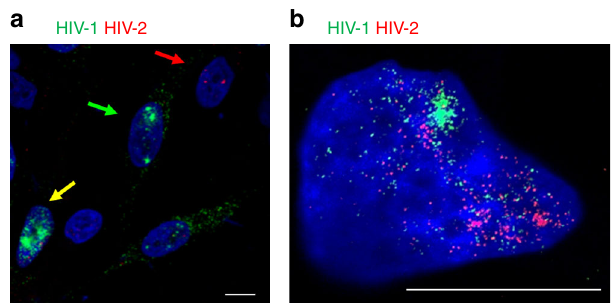
Fig. 7 MICDDRP analysis of HIV-1/HIV-2 viral coinfection. TZM-bl cells were infected with HIV-1 and HIV-2 at MOIs of 0.5 and 1, respectively. At 24 hpi cells were fi xed and stained for HIV-1 (PS-2; green) and HIV-2 (PS-5; red) vRNA, and nuclei (blue). Images were captured with a an Olympus IX81 microscope, or b a Leica STED super-resolution system. Scale